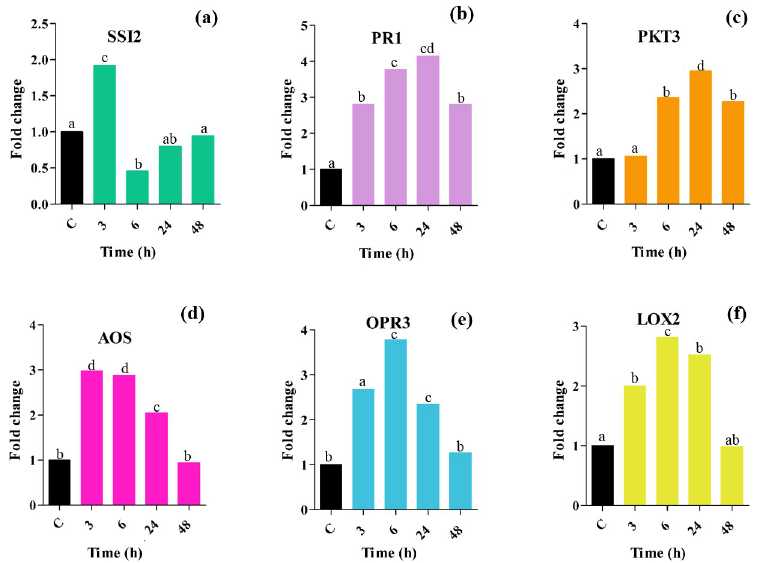
Fig 11. Relative expression analysis of hub genes. The expression of hub genes at the time points of 3 h, 6 h, 24 h, and 48 h after 100 μ M MeJA treatment. The different letters on the columns represent the significant differences given by Duncan’s multiple range statistical analysis. Vertical bars indicate ± SE of the mean (n = 3, P-value � 0.05). The X-axis shows the times after MeJA treatment.